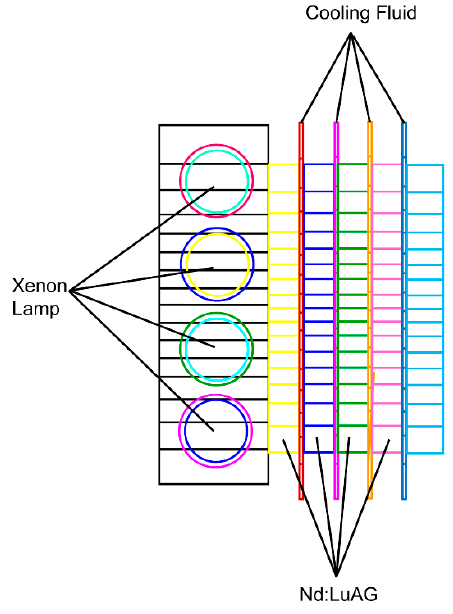
Figure 5. Schematic diagram of the xenon pump radiation.